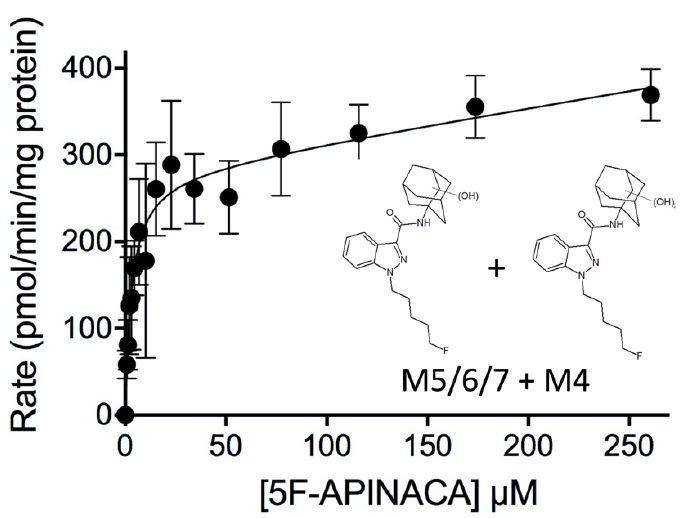
Figure 6. Kinetic profile for overall oxidation of the adamantyl group of 5F-APINACA. The kinetic data for mono- and dihydroxylation of 5F-APINACA (M4, M5, and M6/M7) were combined into one kinetic profile for analyzing the overall efficiency of adamantyl oxidation. The displayed curve reflects the best-fit model for the data. The corresponding mechanism and constants are reported in Table 2.